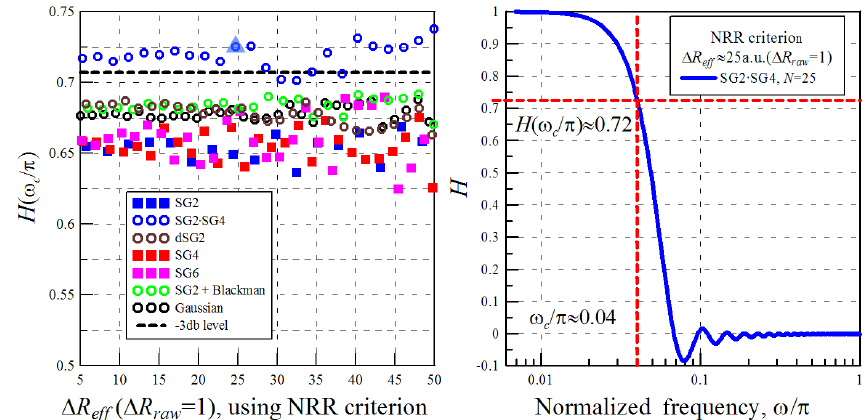
Figure 14. Left plot: the value of the frequency responses function at ω c /π plotted as a function of the effective resolution (Eq. 22, NRR criterion), for all the examined low-pass filter. Right plot: a sketch of the procedure to estimate the single value of the frequency response at ω c /π , in the case of the point indicated by the blue triangle in the left plot: according to Eq. (22), the value of ω c /π is about 0.04 and the corresponding H (0.04) is ≈ 0 . 72.